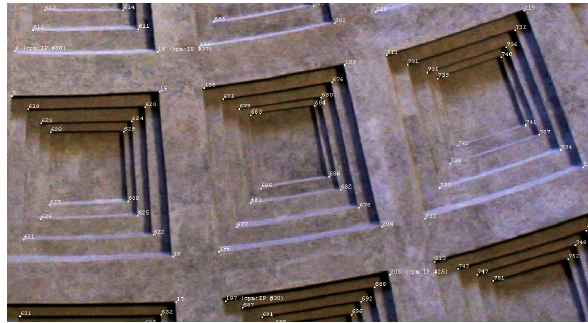
Figure 2. View of vertices points obtained by photogrammetry.